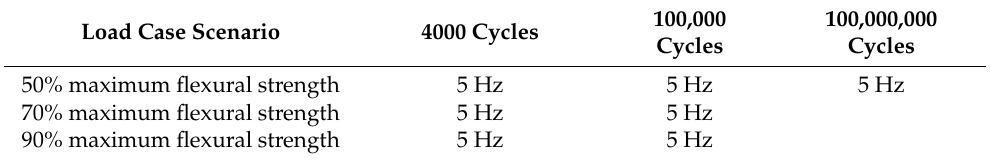
Table 4. Load case and number of